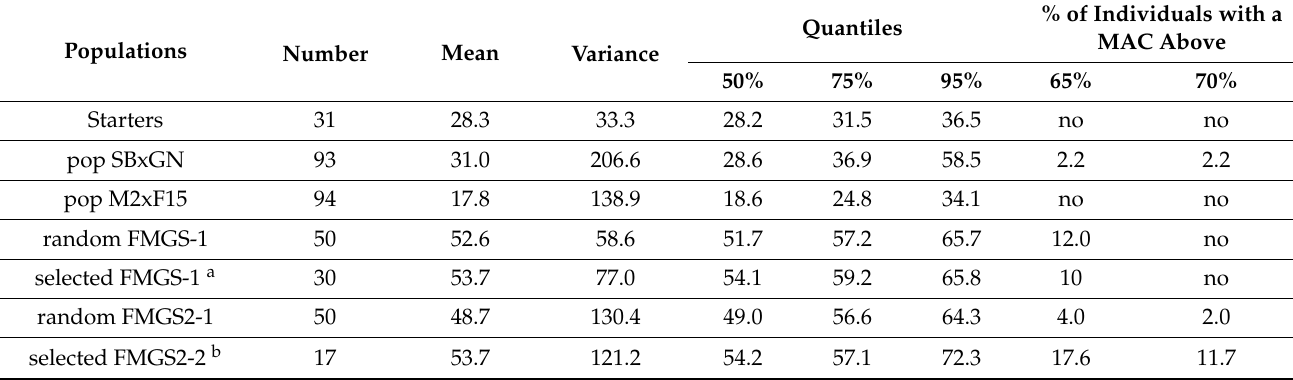
Table 2. Biometric comparison of the populations